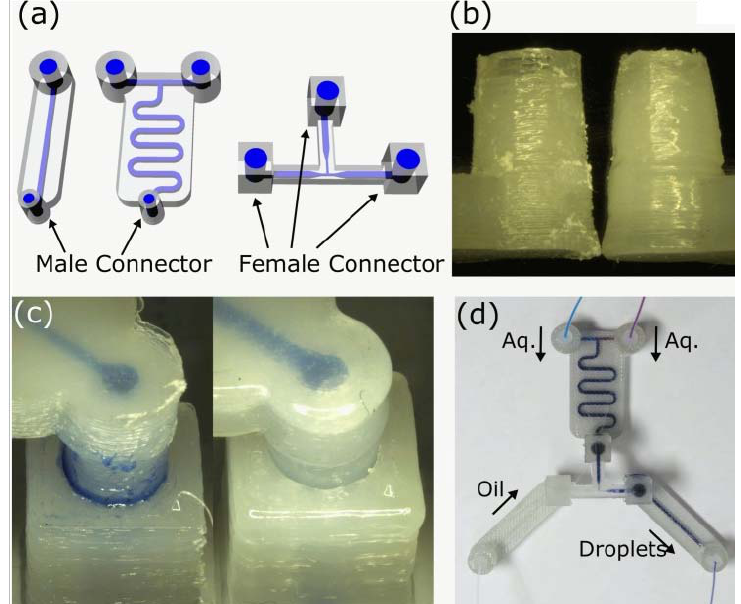
Figure 22. ( a ) Modularised 3D ‐ printed device CAD designs; ( b ) Surface roughness differences between untreated male connector (left) and vapor ‐ treated connector (right). ( c ) Close view of connected male/female parts; ( d ) Assembled modular devices. (Reproduced with permission from [24].)